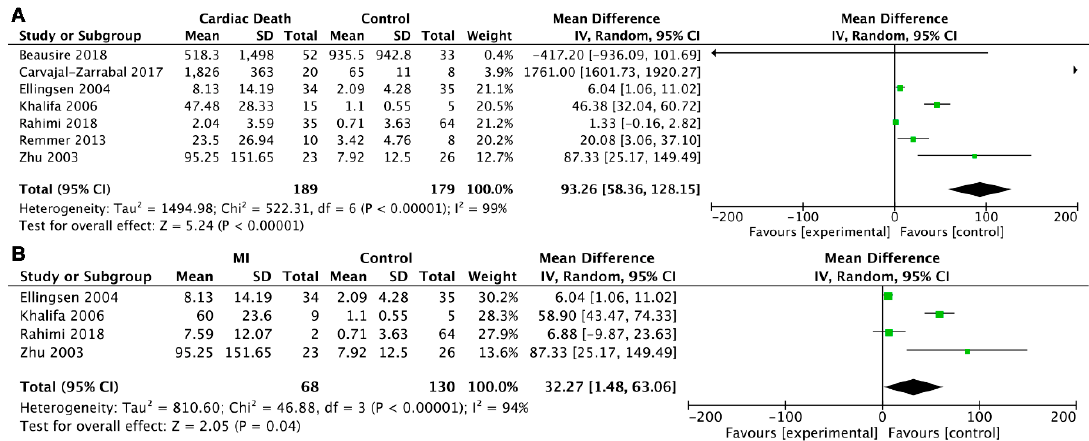
Figure 4. Forest plot of cTn I in serum: (A ) comparison of serum cTn I between cardiac death and control groups; ( B ) comparison of serum cTn I between the myocardial infarction (MI) and control groups.